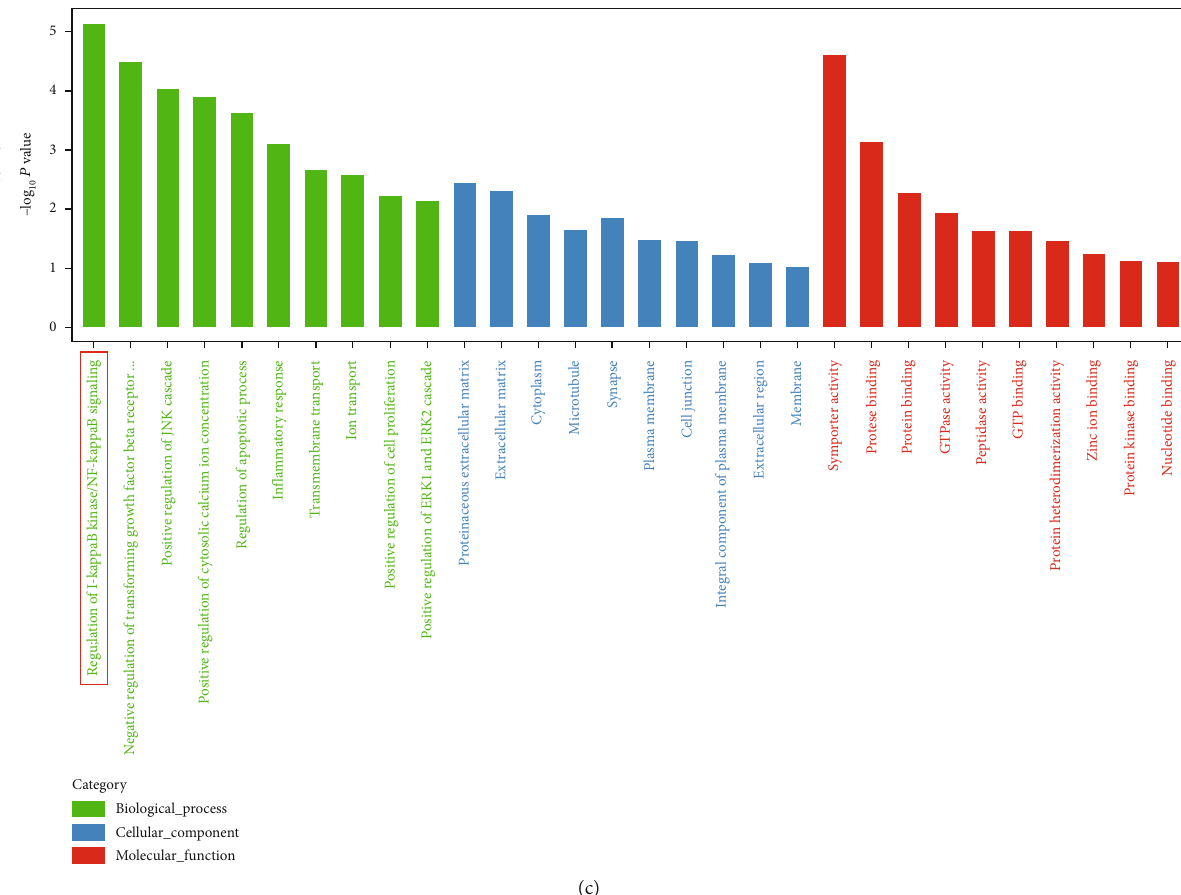
Figure 7: GO term enrichment analysis of di ff erentially expressed genes, including cellular component, biological process, and molecular function. (a) GO annotation analysis between MCAO and sham groups. (b) GO annotation analysis between HIIT and MCAO groups. (c) GO annotation analysis between HIIT and MOD groups. Abbreviation: GO: Gene